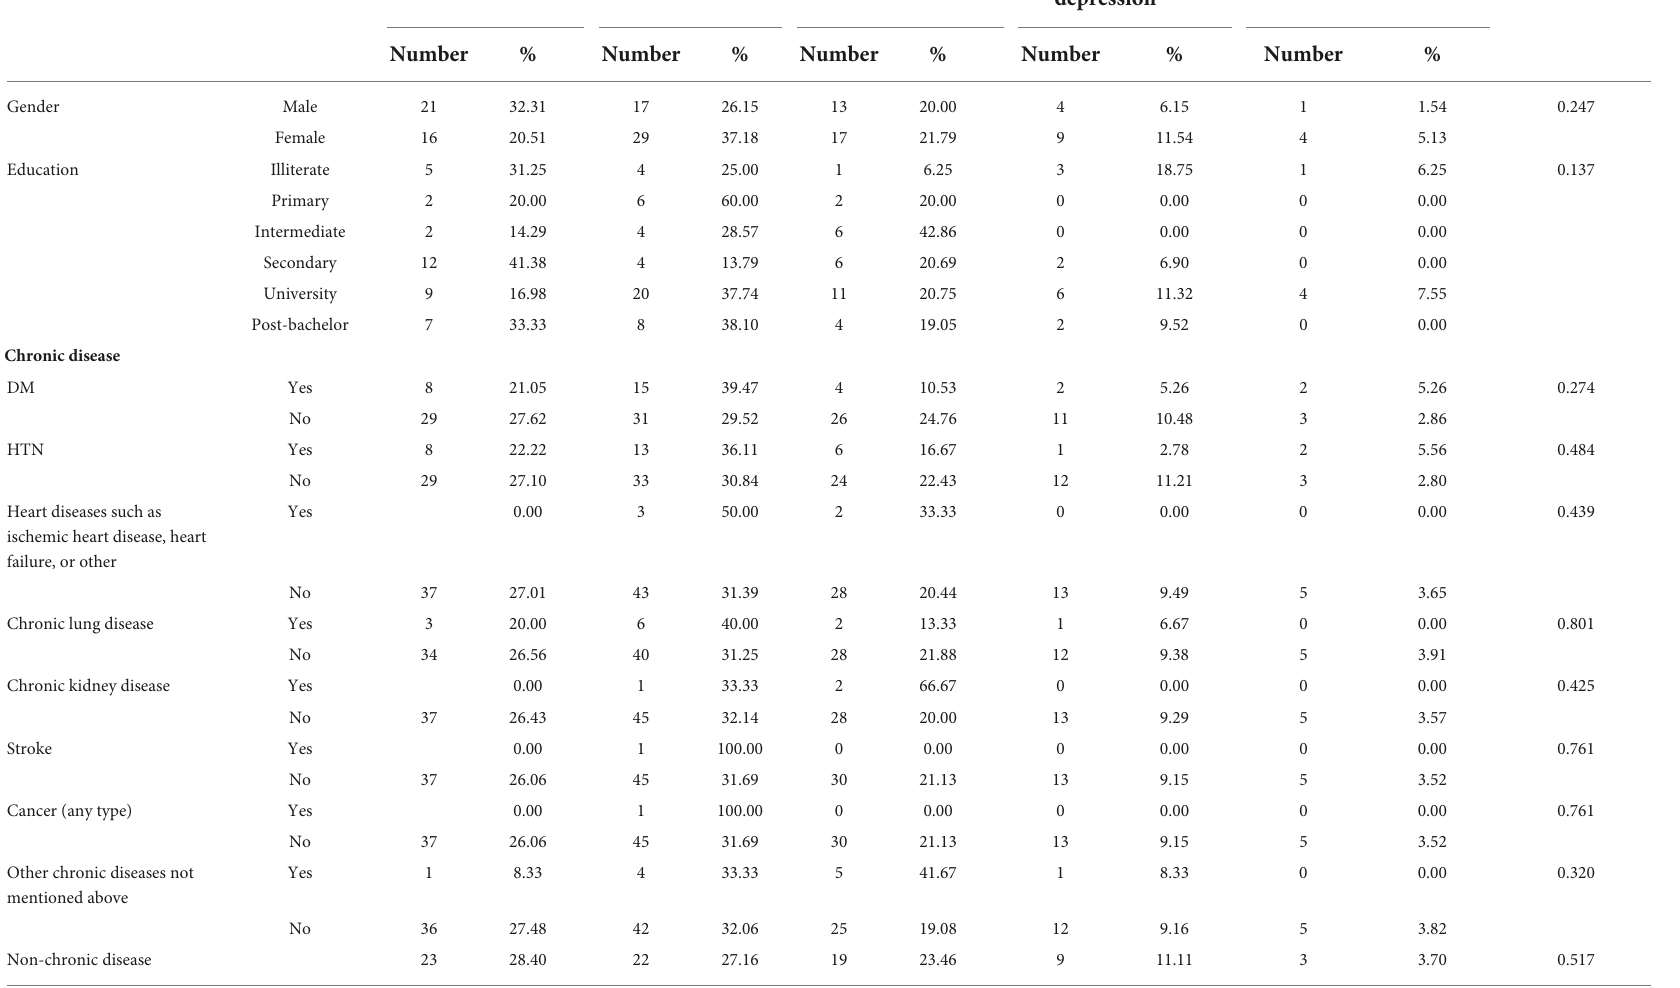
Severe depression P depression